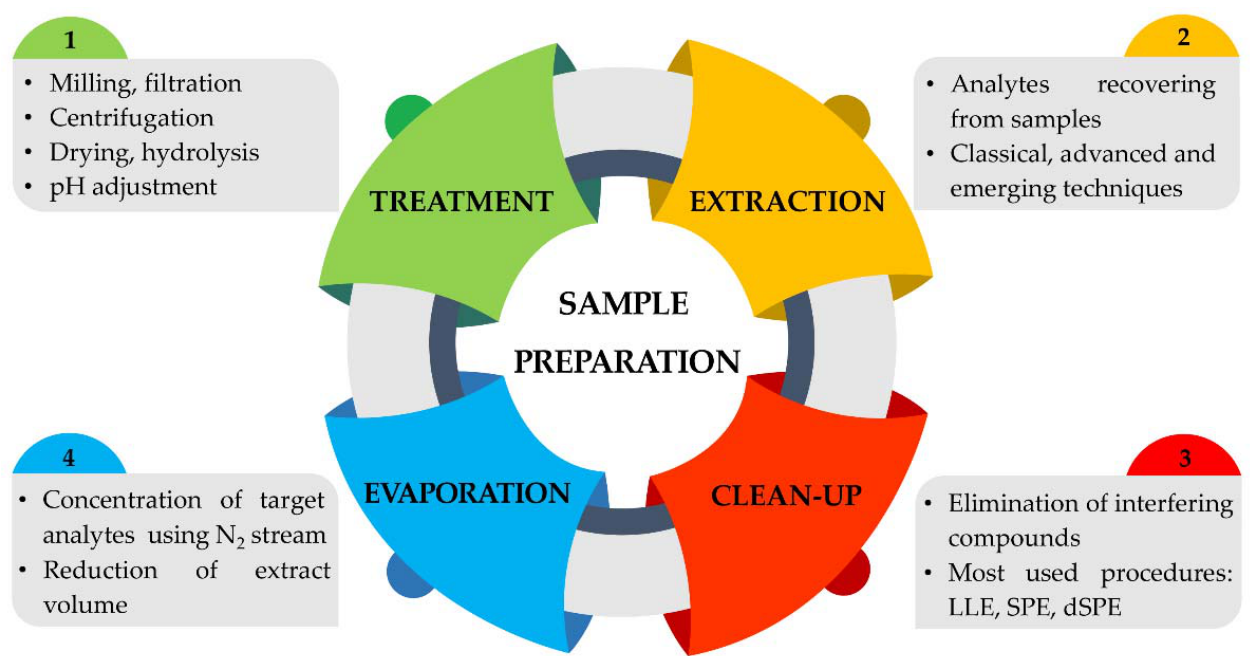
Figure 1. Different steps involved in sample preparation.